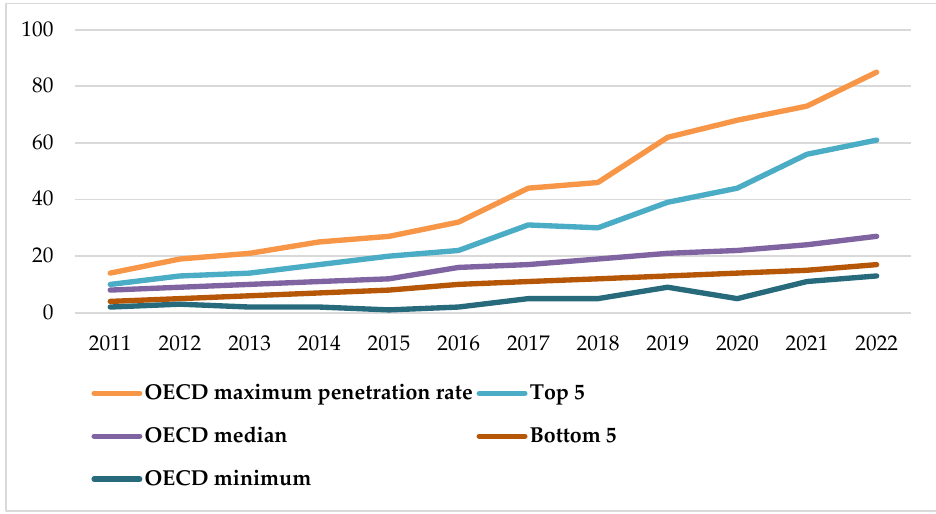
Figure 9. Differences in penetration rates across nations, 2011 to 2022. Source: Adapted from Ref. [77].